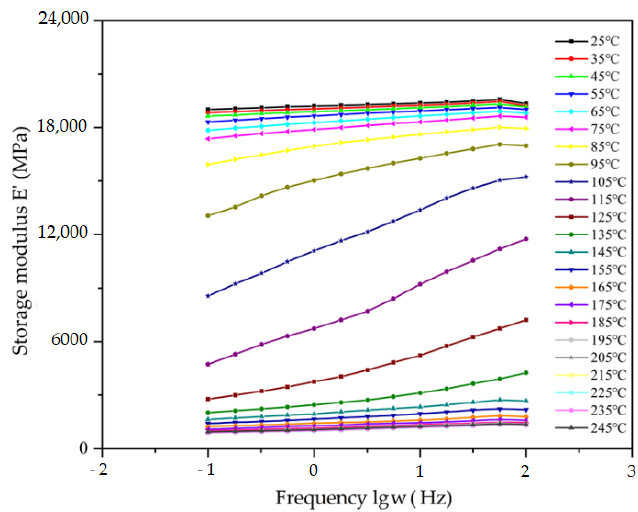
Figure 6. Storage modulus vs. frequency under different temperatures.